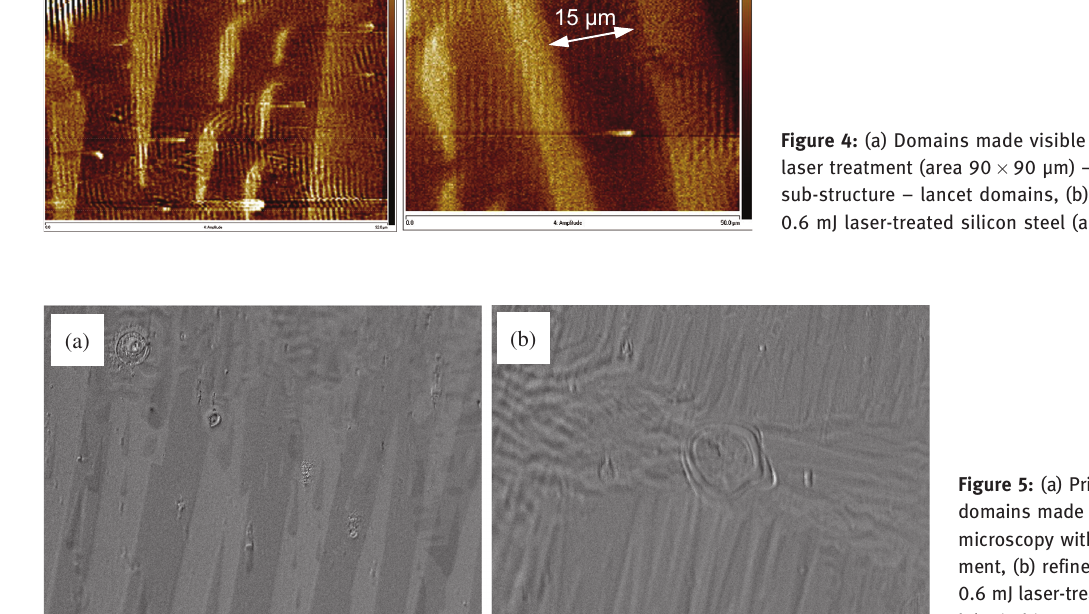
Figure 5: (a) Primary magnetic domains made visible by KERR microscopy without laser treat- ment, (b) refined domains in the 0.6 mJ laser-treated silicon steel – labyrinthine structure near the laser